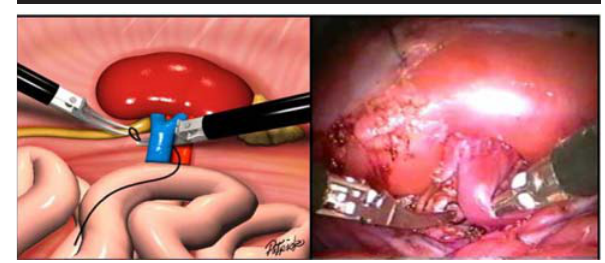
FIGURE 1 - The suture is passed behind the renal vein; the loop at the end of the thread helps the grasper on the left hand to hold the suture.